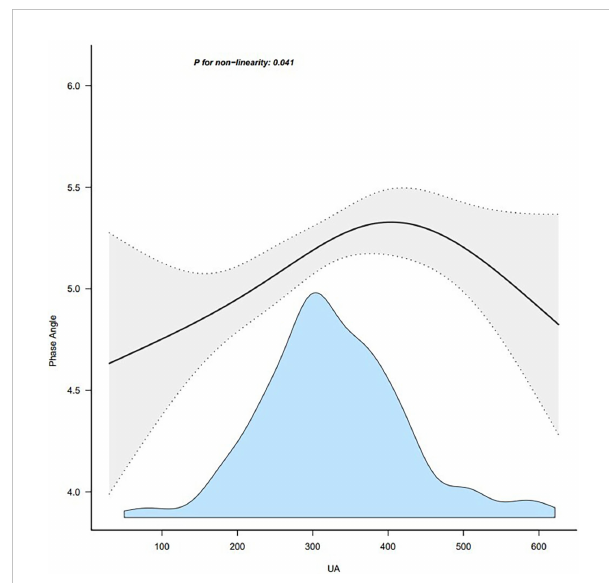
FIGURE 2 Association between UA and phase angle. Note: adjust for age + duration + body mass index. UA, uric